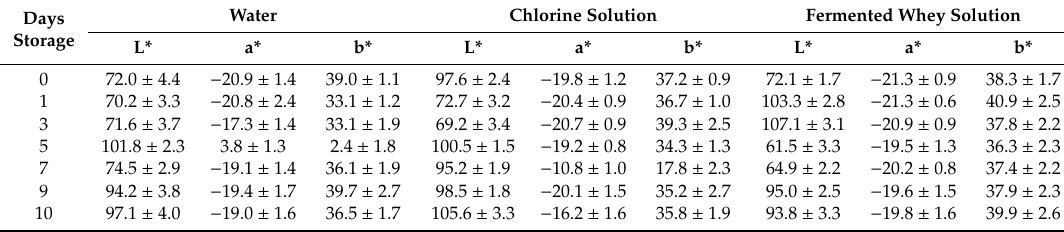
Table 4. Lightness (L*) color parameter of the lettuce after sanitizer treatments, over 10 days in cold storage. Results represent the average of at least three replicate experiments (n = 3) ± SD.